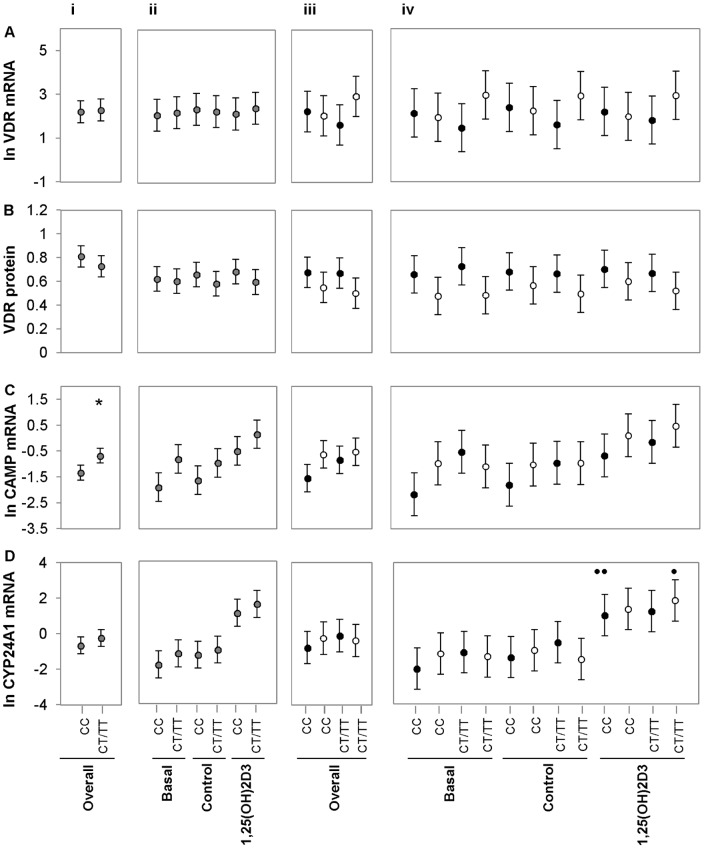

FokI influence VDR function, but not expression.Error-bar plots illustrate the mean level of VDR expression (A), VDR protein (B), CAMP expression (C) and CYP24A1 expression (D) differentiated by FokI genotype (CC and CT/TT). Data was analysed combining ethnicity (i and ii, grey dots, n = 57) or differentiating ethnicity (iii and iv, Africans [n = 38], black dots and Whites [n = 19], white dots). Data was further analysed combining (overall, i and iii) or separating treatments (ii and iv). VDR expression and protein level was not significantly influenced by FokI genotype. Combining ethnicity and treatment (overall), CAMP mRNA level was significantly higher in the CT/TT genotypes compared to the CC genotype (* P<0.050). 1,25(OH)2D3-elicited induction of CYP24A1 mRNA was significant in Africans with the CC genotype (P<0.010, n = 26) and in Whites with the CT/TT genotypes (P<0.050, n = 12). Error bars display the LSD for each data set with Bonferroni correction. All significances indicated withstood Bonferroni correction.